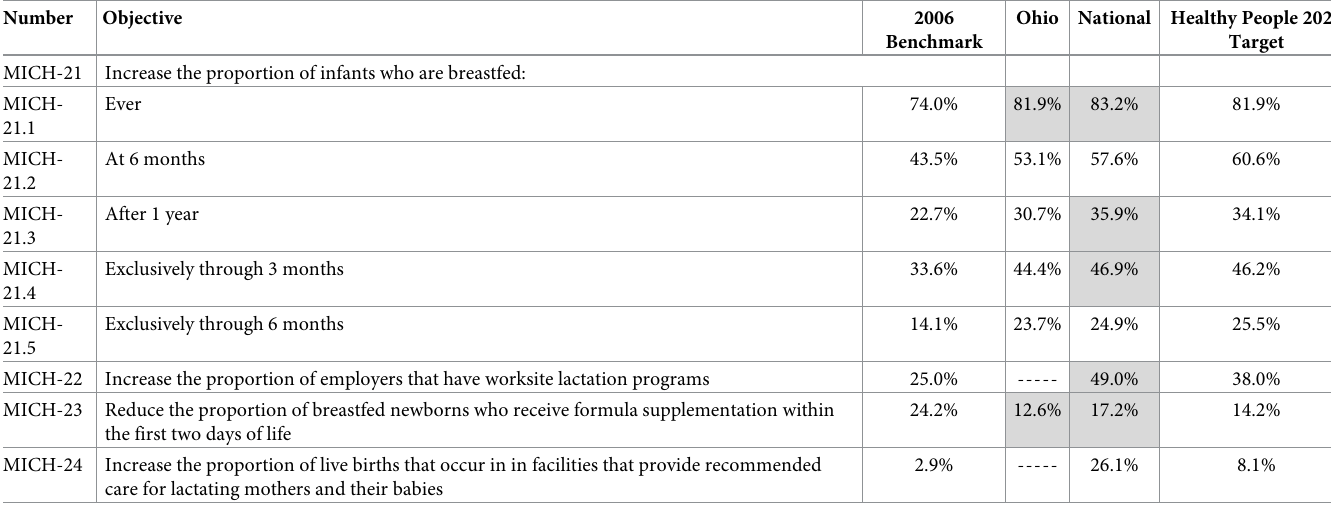
Table 1. Healthy people 2020 breastfeeding targets and realized rates for